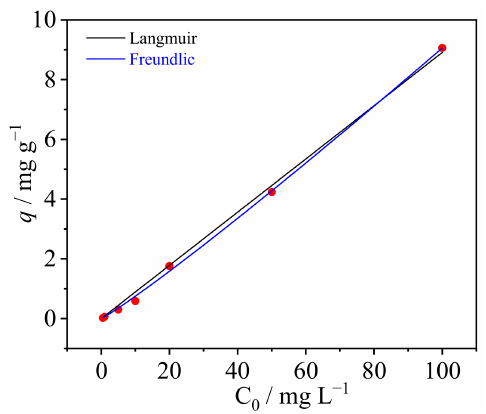
Figure 9. Corresponding experimental data fitted in the Langmuir and Freundlich